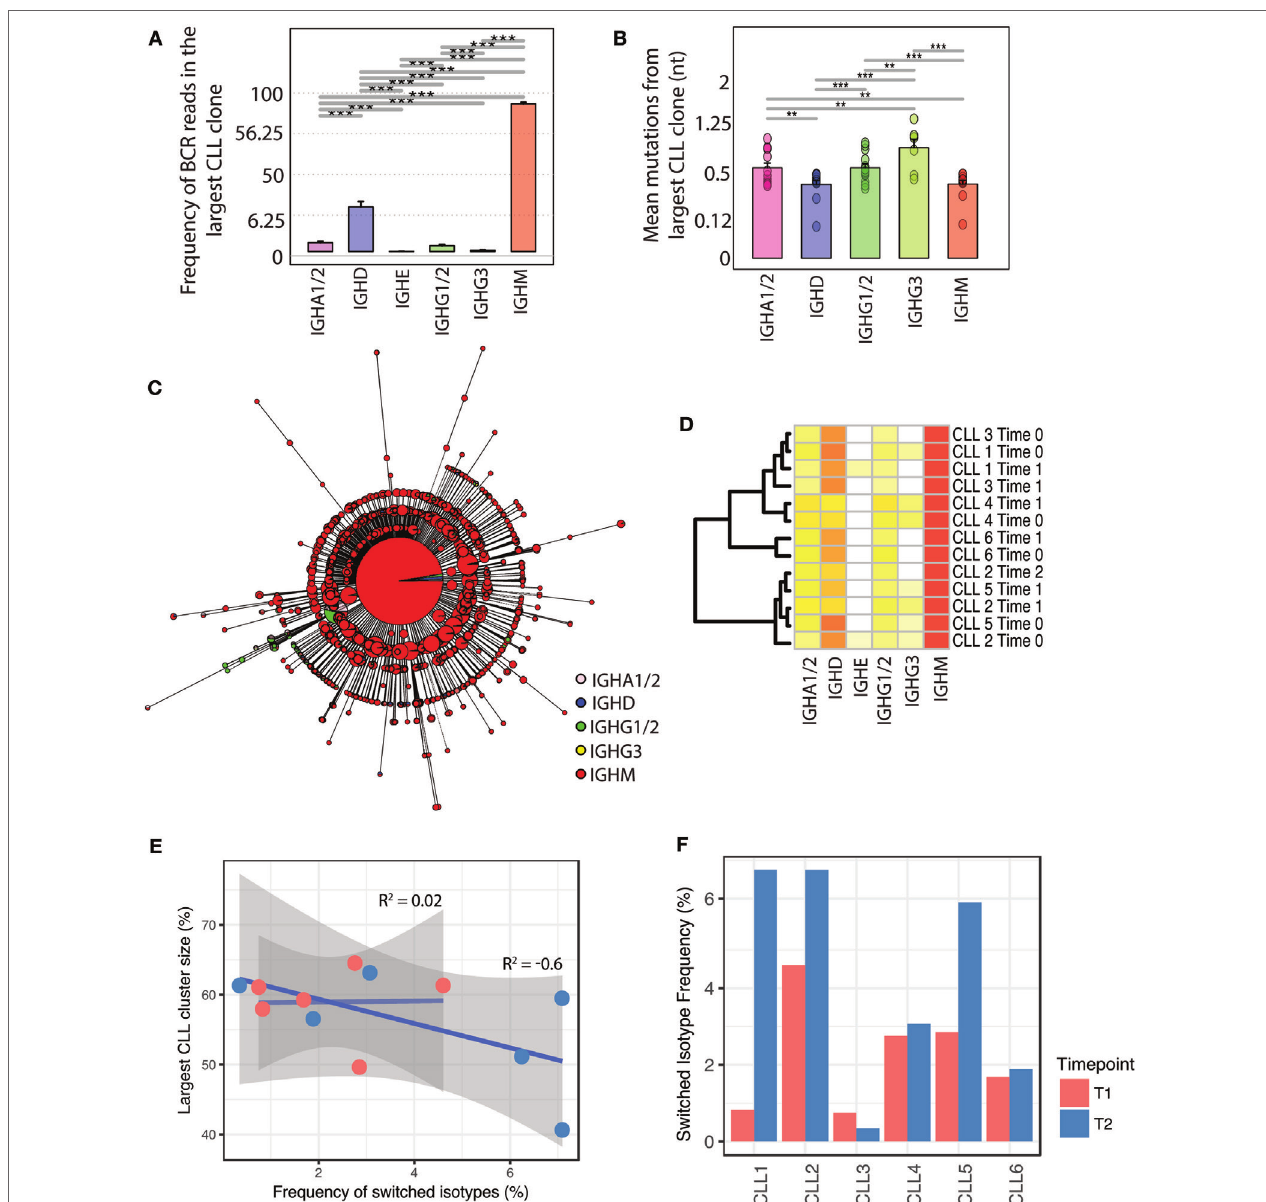
FigUre 3 | Relationship between somatic hypermutation, class-switching, and clonal expansion in the evolution of malignant B-cell clones. (a) Isotype composition of the largest CLL clone across all leukemic individuals. Isotype frequency was calculated as the percentage of reads in the CLL clone corresponding to a given isotype, on a square-root scale to distinguish between low frequency isotypes. (B) Number of mutated nucleotides in IGHV genes of B-cell receptors (BCRs) of different isotypes compared to the IGHV gene of the major leukemic CLL clone for each sample. (c) Unrooted phylogenetic tree of an example class-switched CLL clone. Each tree tip represents a unique BCR sequence, the pie charts represent the proportion of isotypes per unique BCR, and size corresponds to the proportion of BCRs represented by that sequence (square-root scale for visualization). (D) Heatmap of isotype frequency in total CLL repertoires of the six leukemic patients across timepoints of longitudinal sampling (see Table S4 in Supplementary Material). (e) Relationship between degree of class-switching and CLL clone size; the x -axis represents the total frequency of switched BCRs in the malignant CLL clone for each individual (represented as a dot). The y -axis reflects the size of the major CLL clone per individual shown as number of BCRs per individual contributing to the largest CLL clone (as a percentage of the total BCR repertoire). The correlation coefficient labels represent the correlations between percentage switched isotype per largest CLL clone and size of the largest clone for the two sampling points. (F) Frequency of switched BCR in the CLL malignant clones of each patient calculated for the two sampling points (T1 and T2) per sample. For sampling point details, see Table S4 in Supplementary